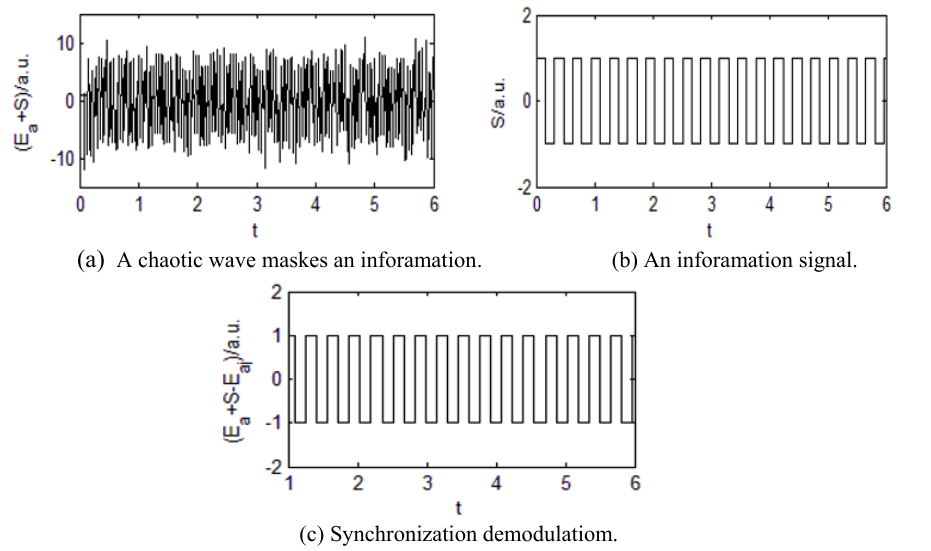
Fig. 5. Chaotic digital coding for secure